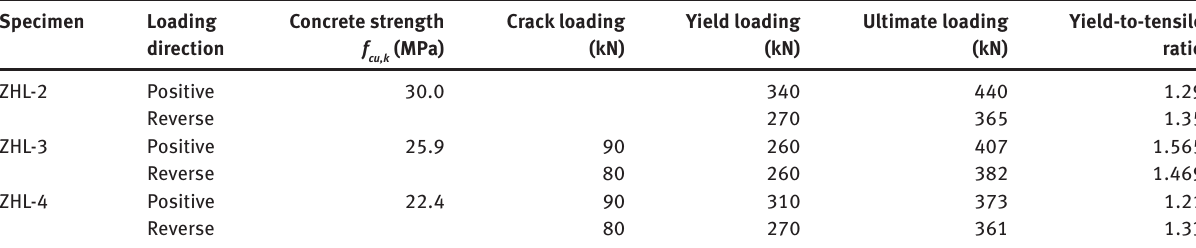
Table 4: The measured loading of transfer beam specimens.